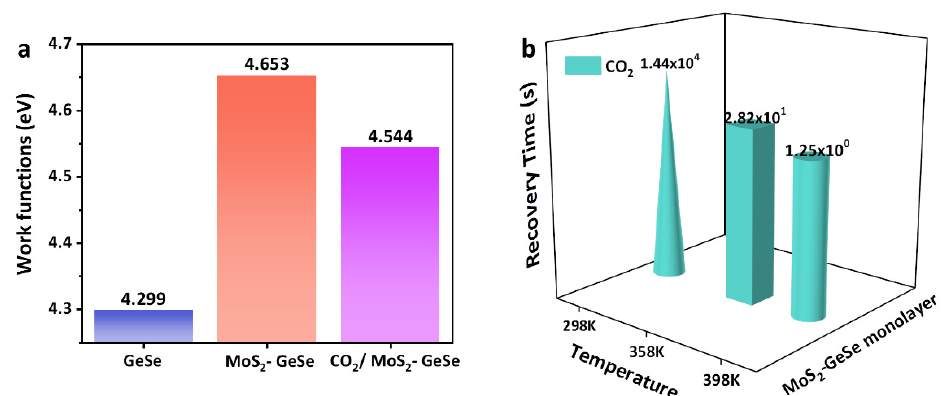
Figure 5. Change trend of WFs ( a ); recovery time at different temperatures ( b ).